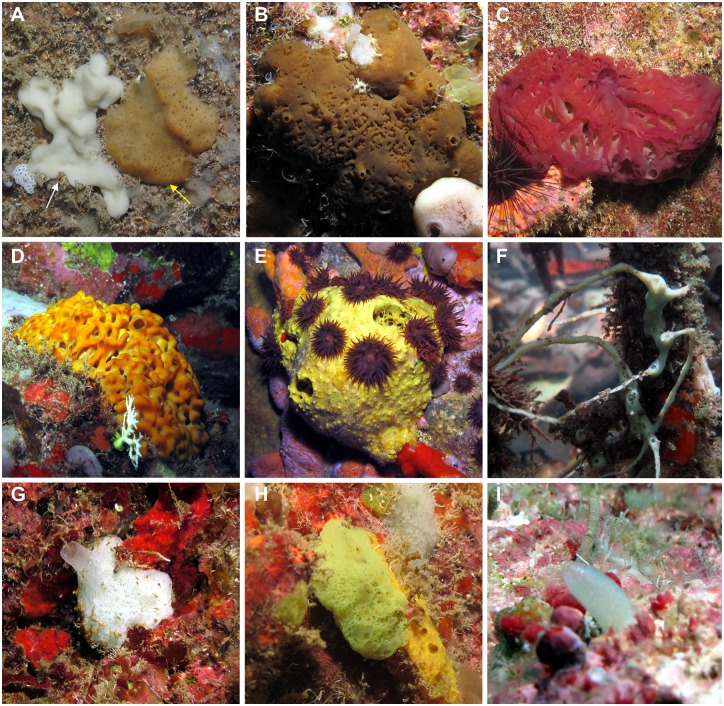
In situ photographs of some new records for the Eastern Caribbean Sea.A) Plakina arletensis (white arrow) next to the first record of Tetralophophora mesoamericana (yellow arrow) in the Eastern Caribbean (“Grotte Chauve Souris”, Anses d’Arlet); B) The aspiculate Plakinidae Aspiculophora madinina (“Grotte Fer à Cheval”, Diamant); C, D) Two different Oscarella species which are new to science (“Grotte Couleur”, Anse d’Arlet); E) A spherical Aiolochroia sp. nov. and its associated sea-anemons (Diamond Rock tunnel); F) A delicately branching Haliclona sp. nov. growing on mangrove roots (Bay of Genipa, Lamentin); G) Leucetta floridina, a new record for the Eastern Carribean (“Grotte Couleur”, Anses d’Arlet); H) Ernstia sp. nov., a new Clathrinidae (“Grotte Couleur”, Anses d’Arlet), I) Leucilla sp. nov., a new Amphoriscidae (“Pointe Burgos, Anses d’Arlet). Pictures A,B,C,D,E,G,H,I by T. Pérez, and picture F by C. Díaz.